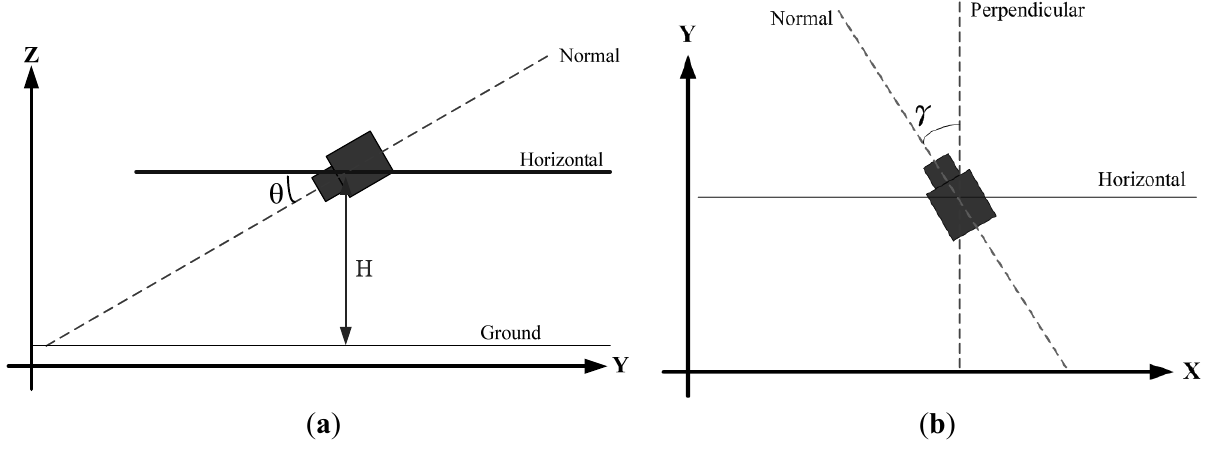
Figure 2. The camera model used in this paper. ( a ) View of the Y-Z plane for height and tilt; ( b ) View of the X-Y plane.